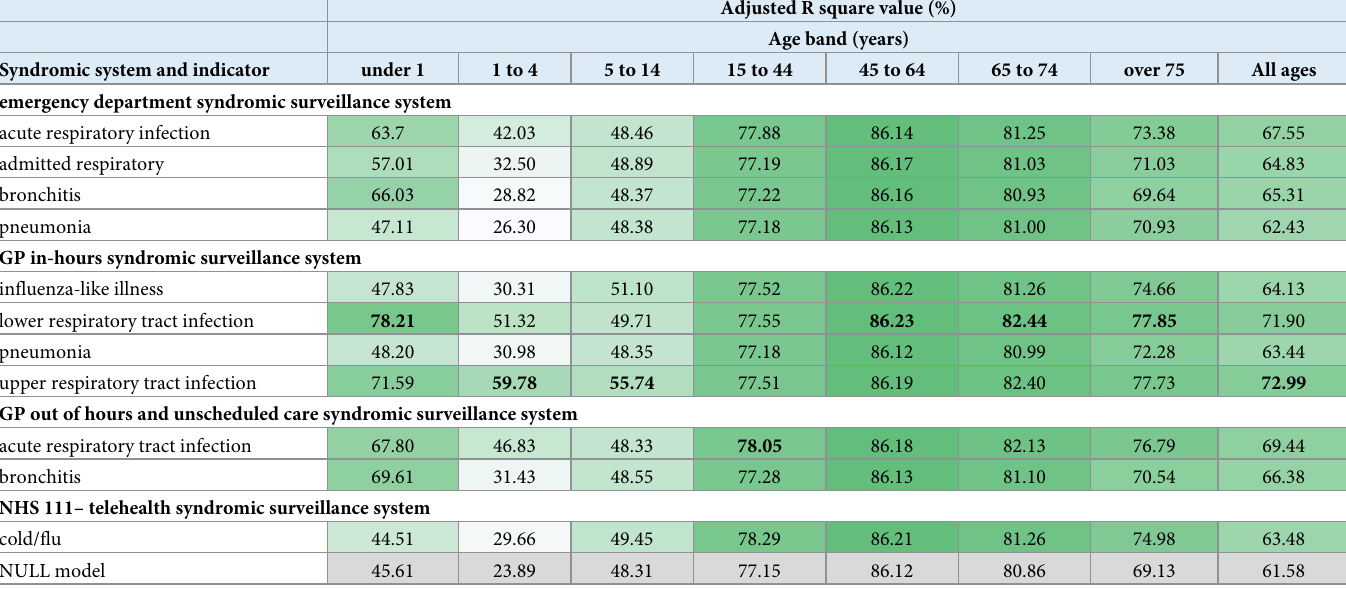
Table 2. Adjusted R square values (%) for regression models measuring association between syndromic indicators and emergency hospital admissions (higher val- ues are depicted with darker shades–highest value in each column shown in bold).